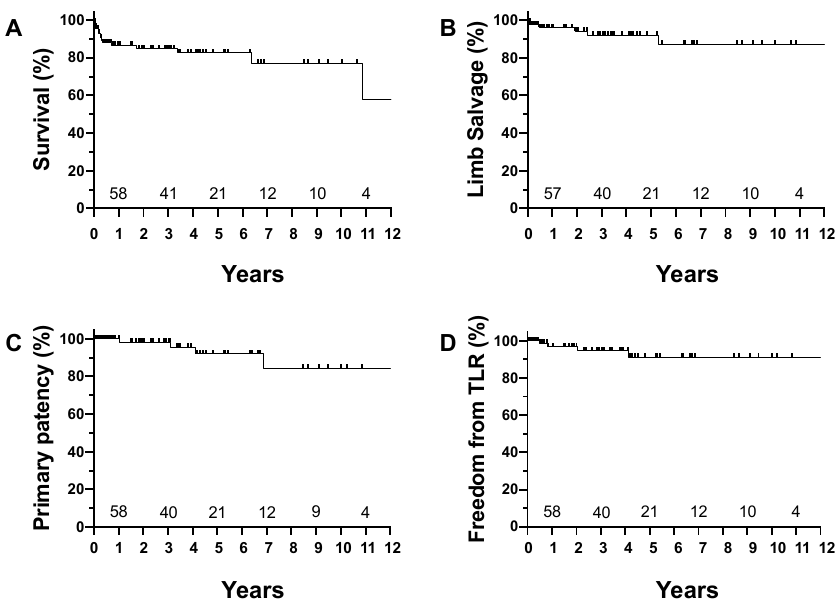
Figure 2. Ten-year outcome after femoral endarterectomy. ( A ) Survival; ( B ) limb salvage; ( C ) primary patency; ( D ) freedom from target lesion revascularization. Numbers at risk are shown above the x-axis.